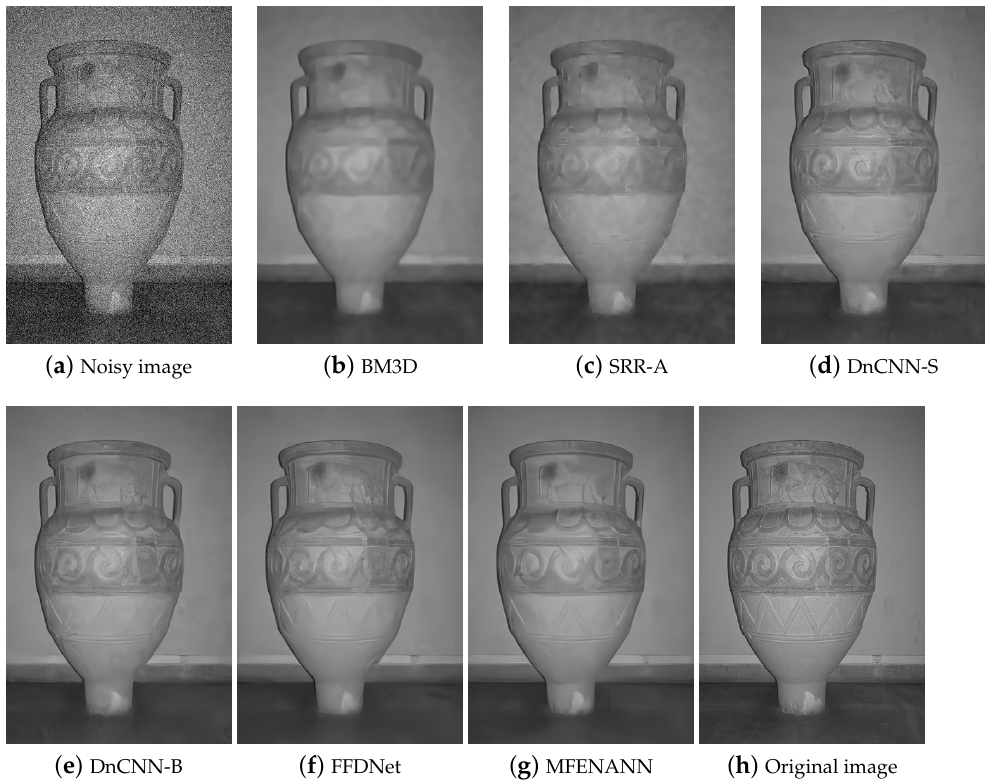
Figure 6. Experimental results of several state-of-the-art algorithms for image “test045” in “BSD68” at a noise level of 25. The PSNR values are: ( a ) noisy image, 20.14dB; ( b ) BM3D, 31.75 dB; ( c ) SRR-A, 32.19 dB ( d ) DnCNN-S, 33.62 dB; ( e ) DnCNN-B, 33.58 dB; ( f ) FFDNet, 33.78 dB; ( g ) MFENANN, 33.95